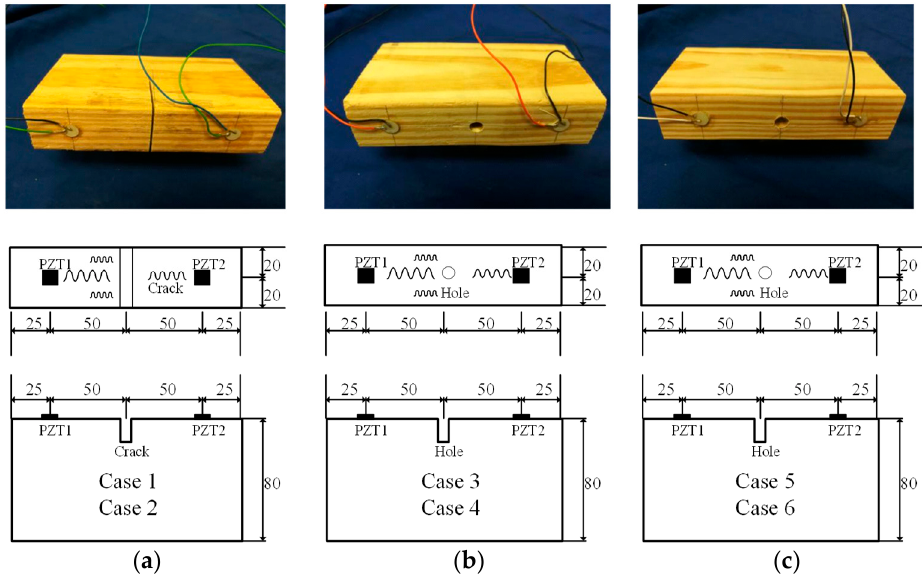
Figure 4. Timber specimens of three groups. ( a ) Specimen of Group A; ( b ) Specimen of Group B; ( c ) Specimen of Group C. ( c ) Specimen of Group C.